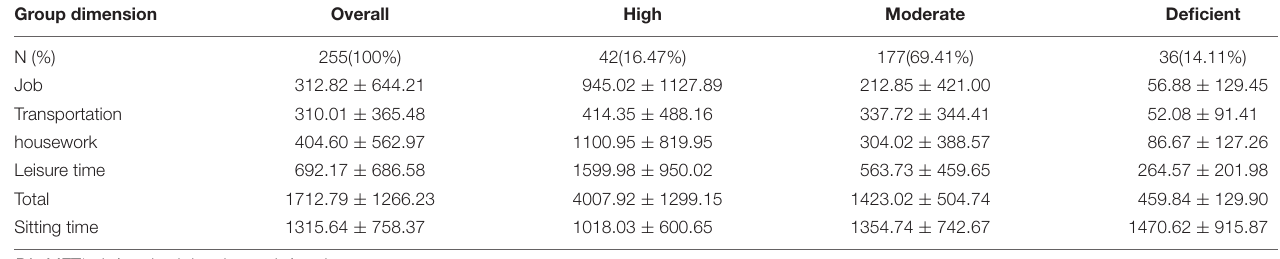
TABLE 2 | Daily PA in patients with T2DM.